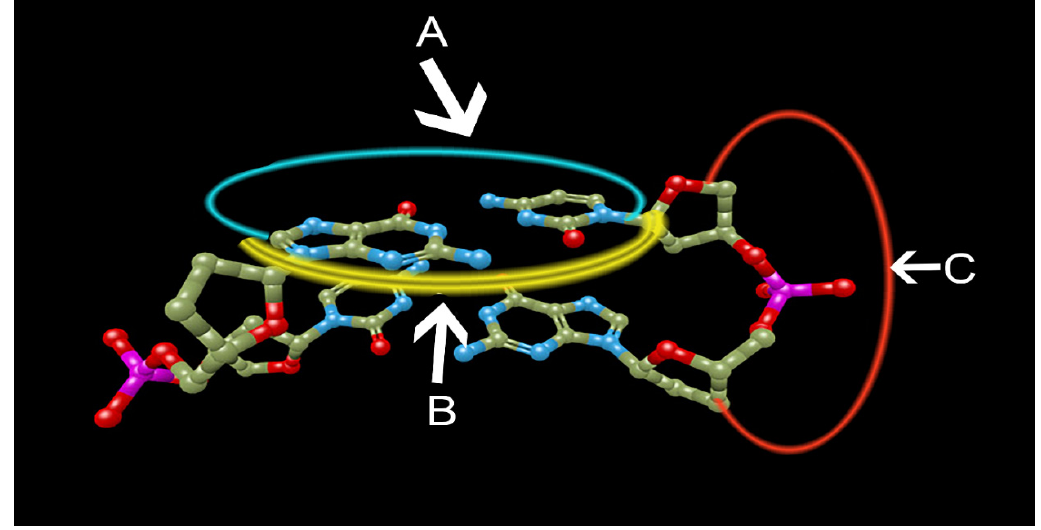
Figure 5. Examples of spatial recognition quizzes: Which letters represent the major and minor grooves?